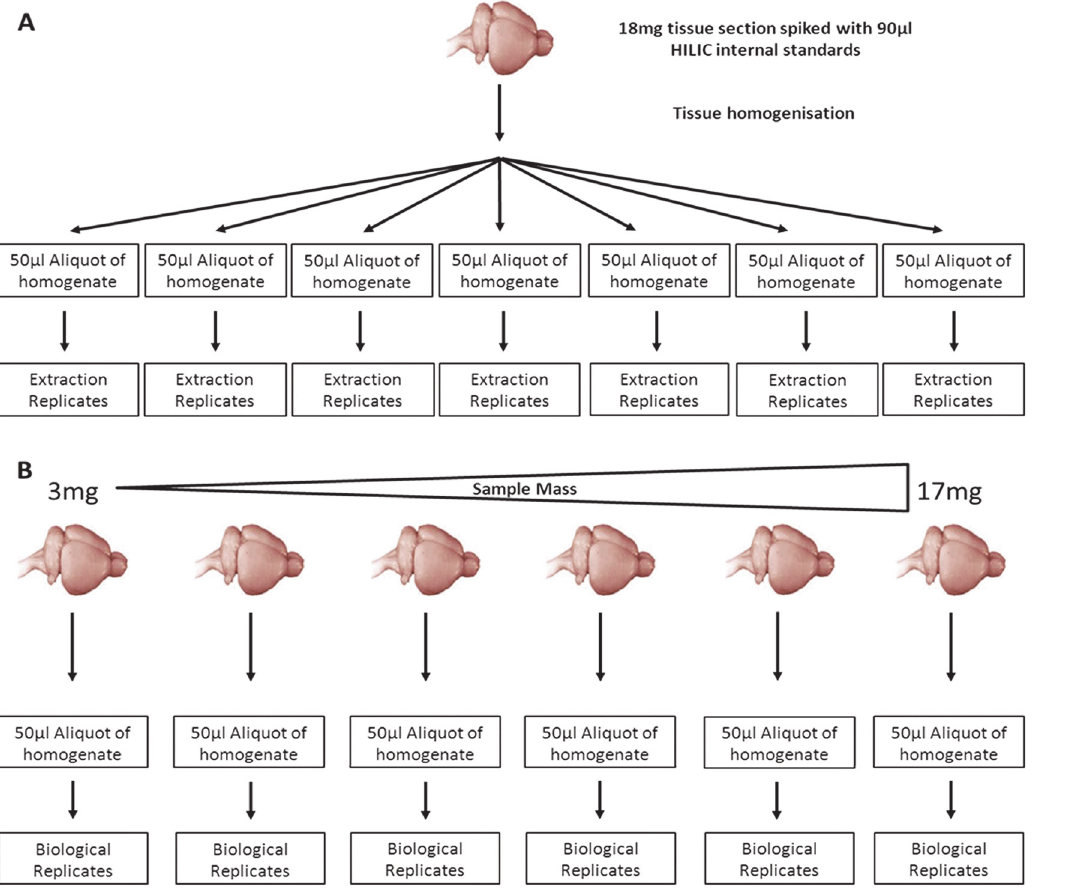
Fig 1. Graphical representation of the experimental designs used. A) experiment 1, a single 18mg brain section was homogenised then 7 parallel extractions were performed on 50 μ l aliquots of homogenate. B) Experiment 2, brain sections ranging from 3 – 17mg were homogenised and extracted